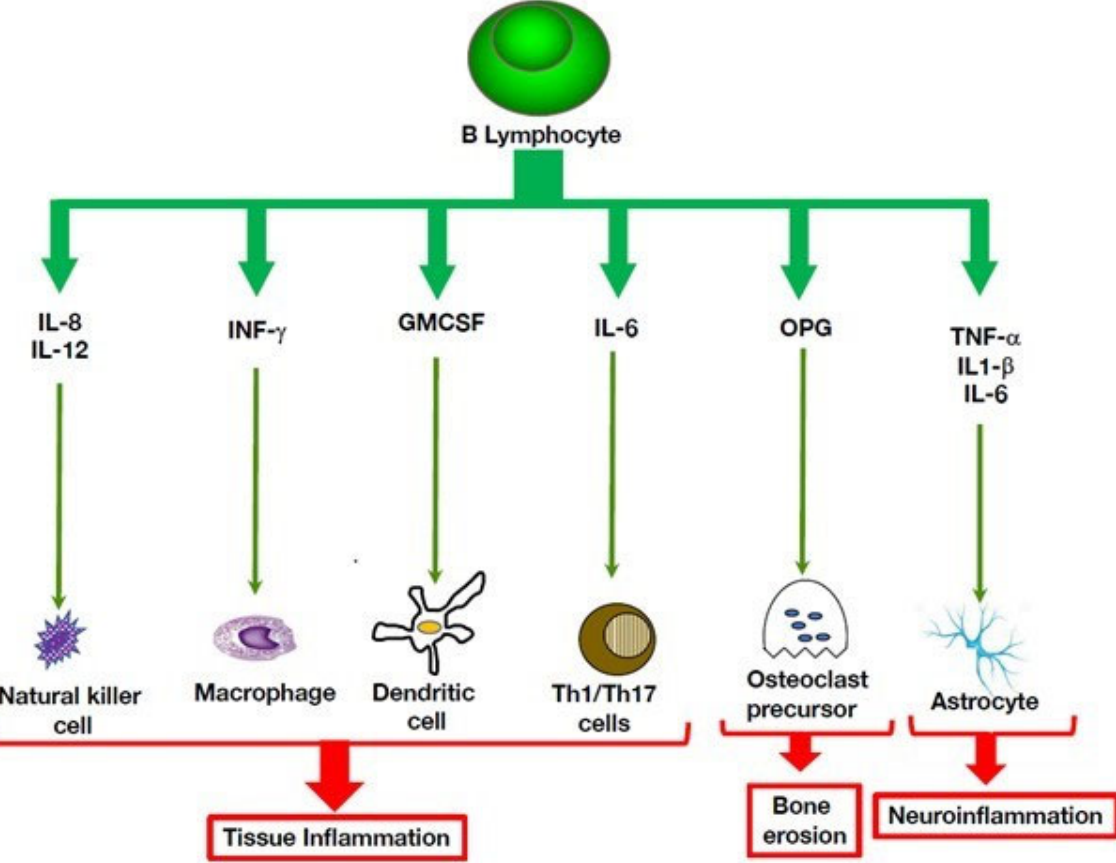
(Figure 1). Given the tight relationships between B lymphocytes and the skeletal system, the role of B cells in autoinflammation in bone disorders deserves further consideration.